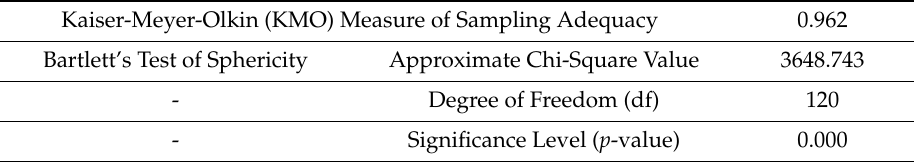
Table 3. Results of the KMO Test and Bartlett’s Test of Sphericity. Kaiser-Meyer-Olkin (KMO) Measure of Sampling Adequacy